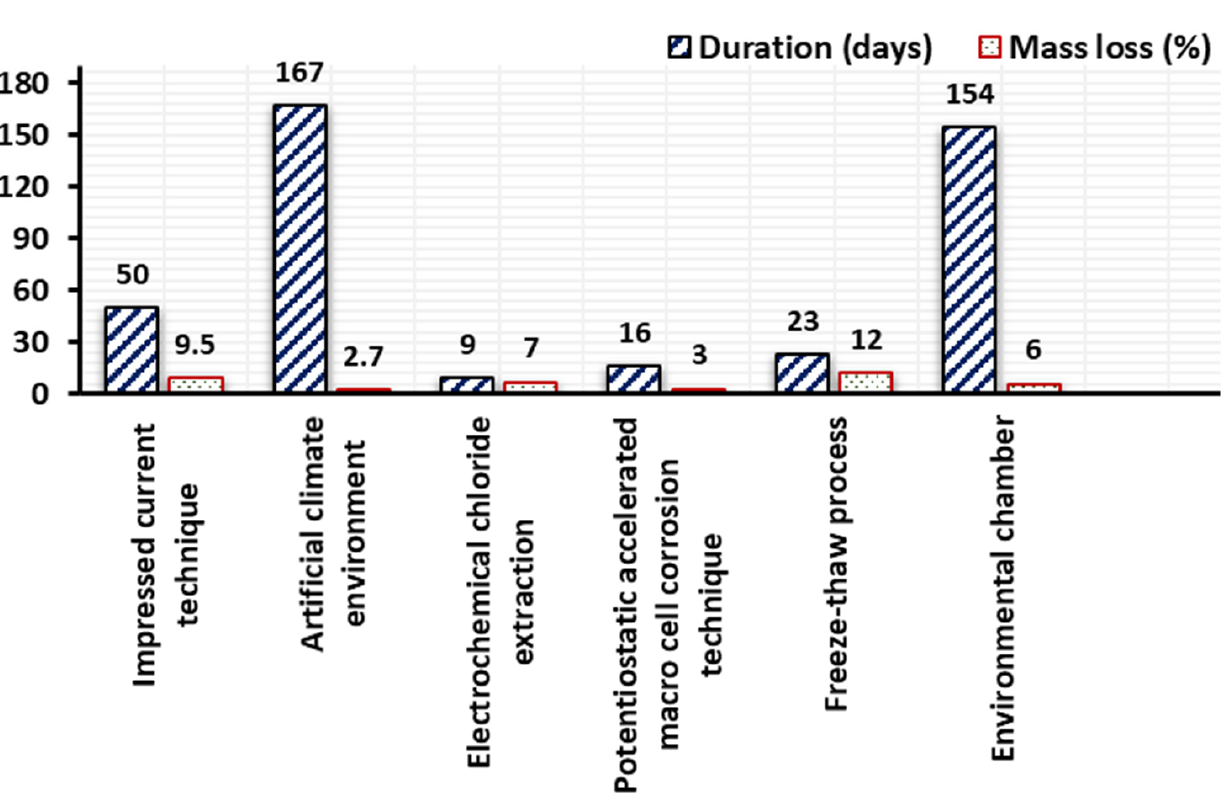
Figure 10. Comparison of di ff erent corrosion methods.